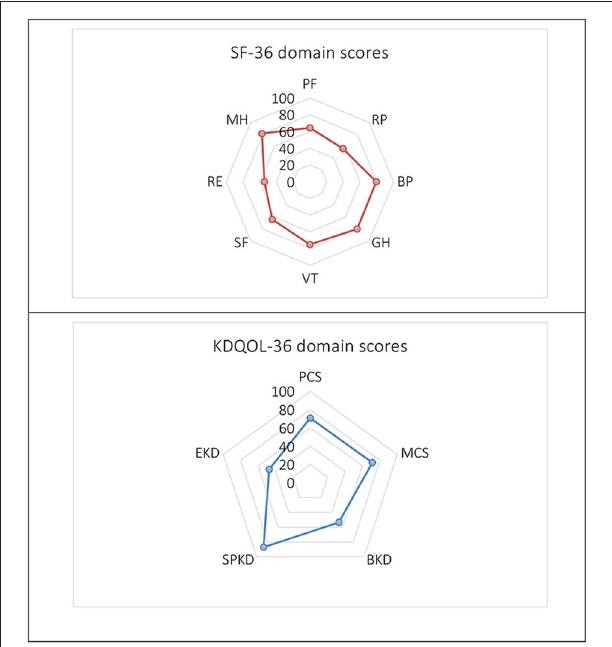
FIGURE 1 | The Short Form 36 (SF-36) and Kidney Disease Quality of Life 36 (KDQOL-36) domain scores. PF, Physical Functioning; RP, Limitations in